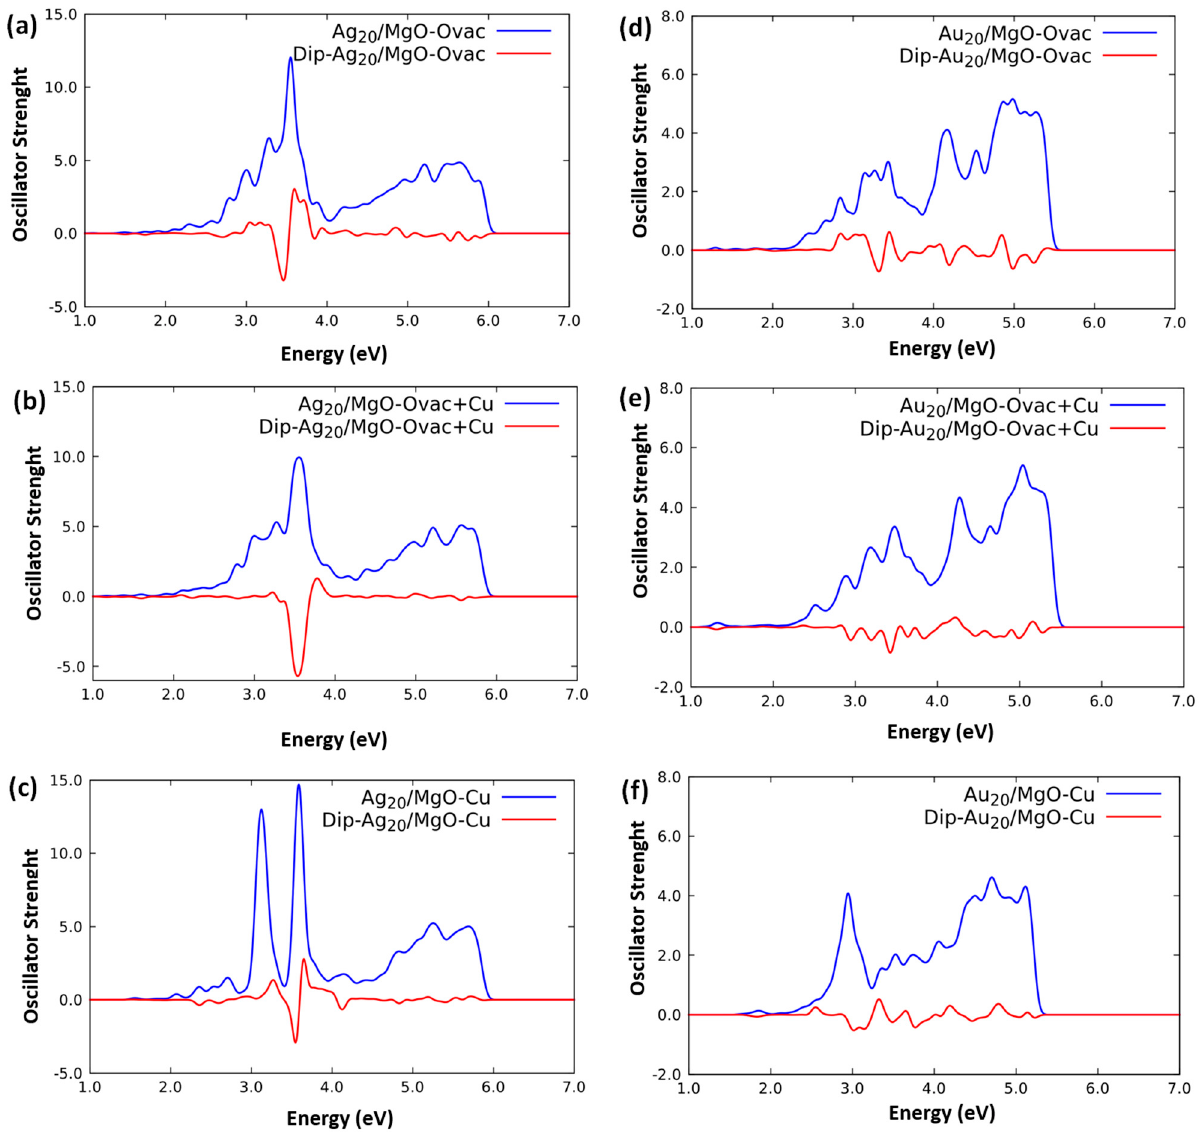
Figure 6. Blue curves: simulated TDDFT/PBE0 photo-absorption spectra of: ( a ) Ag 20 /MgO(100)-Ovac, ( b ) Ag 20 /MgO(100)- Ovac+Cu, ( c ) Ag 20 /MgO(100)-Cu, ( d ) Au 20 /MgO(100)-Ovac, ( e ) Ag 20 /MgO(100)-Ovac+Cu, ( f ) Ag 20 /MgO(100)-Cu, using the ORCA code. Red curves: signed contribution to the oscillator strengths associated with the perpendicular component of the transition dipole moment.